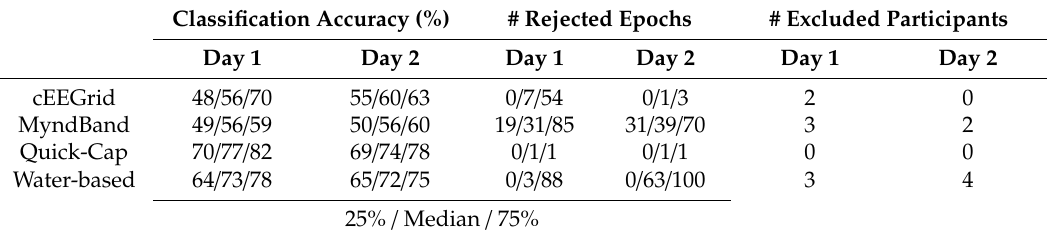
Table 2. Results of the classification analyses for the four headsets. The classification accuracy and number of rejected epochs are presented for both experimental sessions. The results are based on all available channels; therefore, the number of rejected epochs di ff er from Table 1, which was based on a single